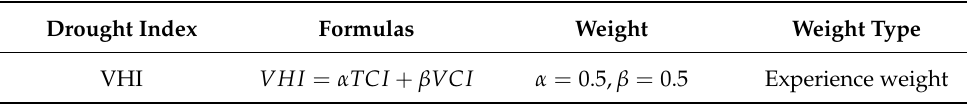
Table 4. Calculation formula for multi-factor drought index. Drought